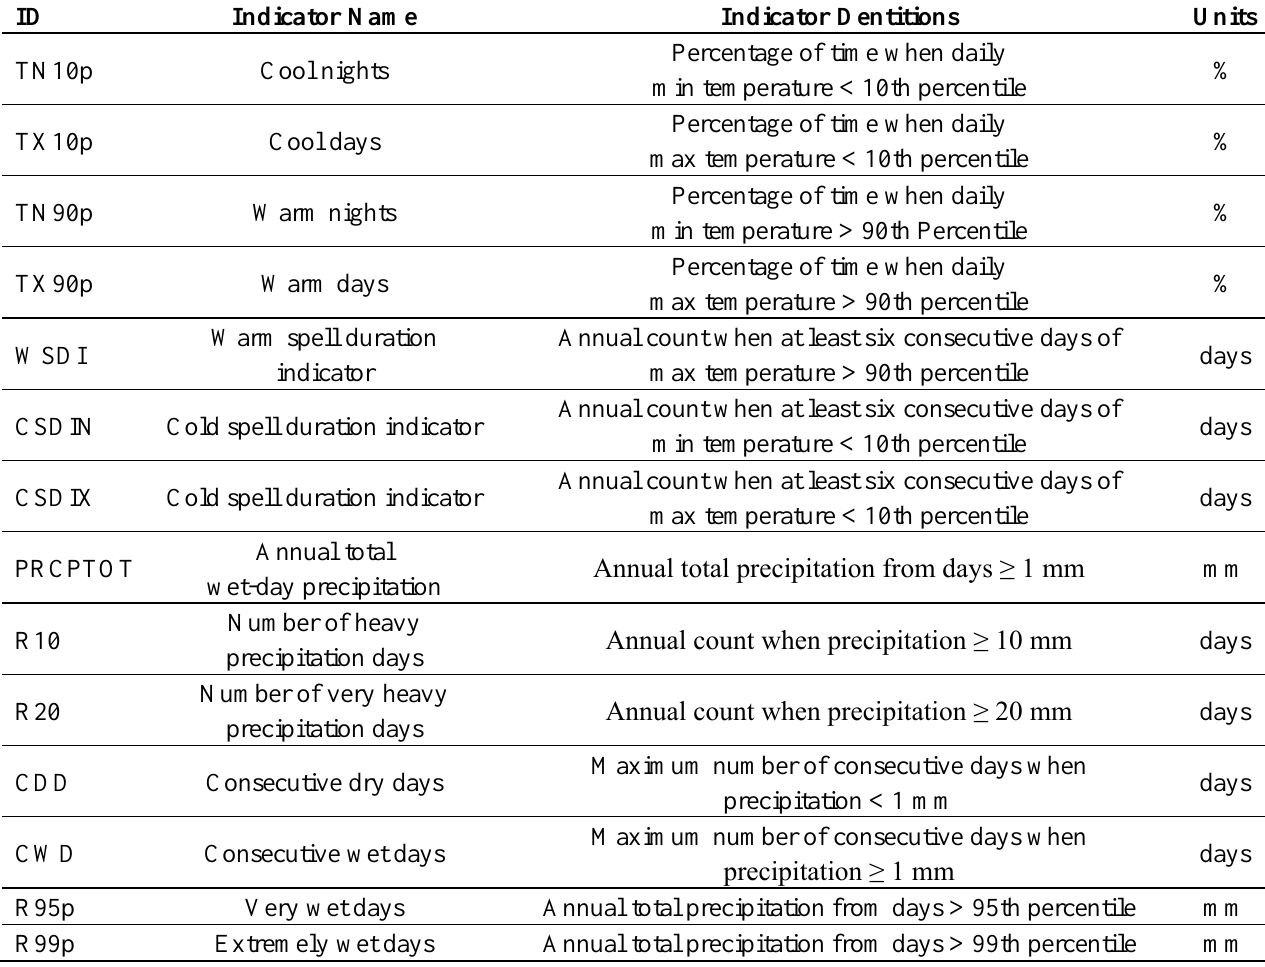
Table 2. The Extreme Temperature and Precipitation